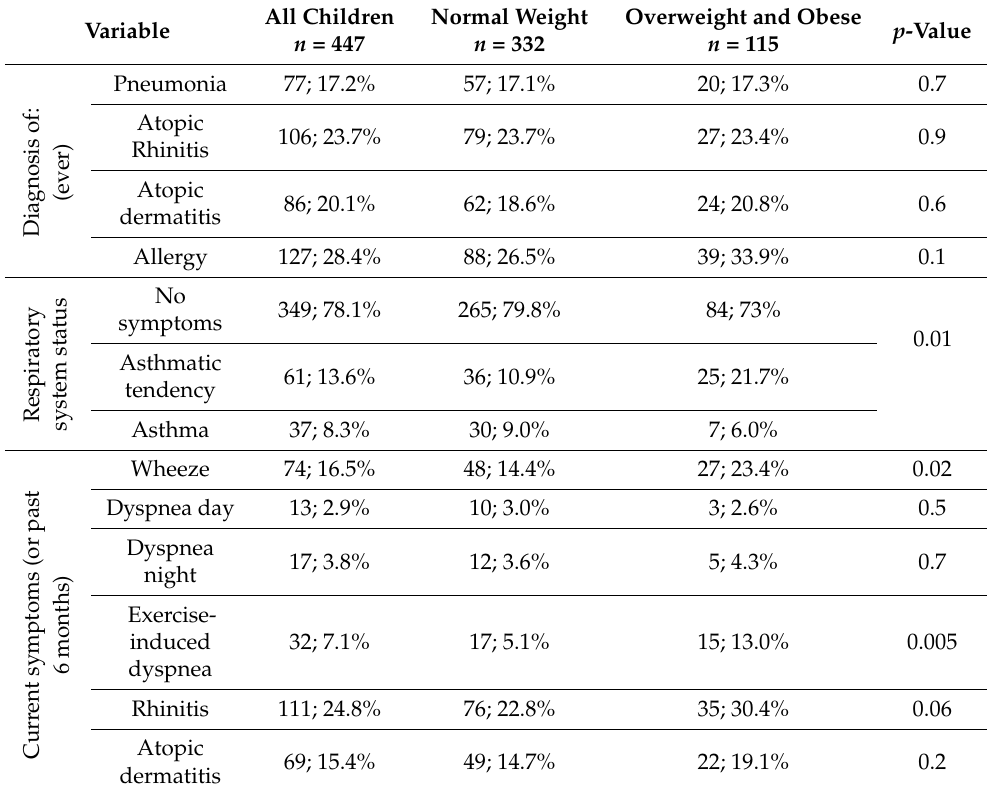
Table 2. Symptoms from respiratory system and diagnoses confirmed by a physician according to BMI status of children included in the